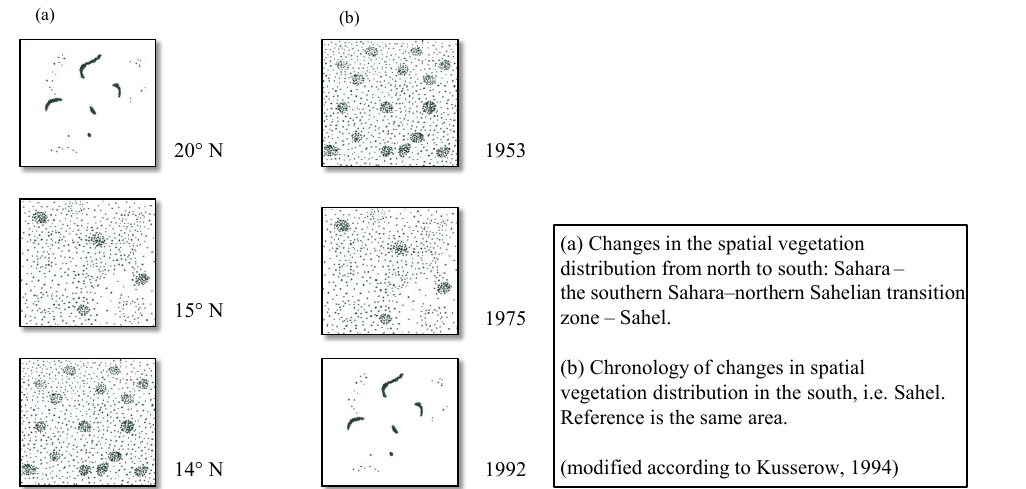
Figure 13. (a) Changes in the spatial vegetation distribution from north to south: Sahara – the southern Sahara–northern Sahelian transition zone – Sahel (modified according to Kusserow, 1994). (b) Chronology of changes in spatial vegetation distribution in the south, i.e. Sahel (modified according to Kusserow,